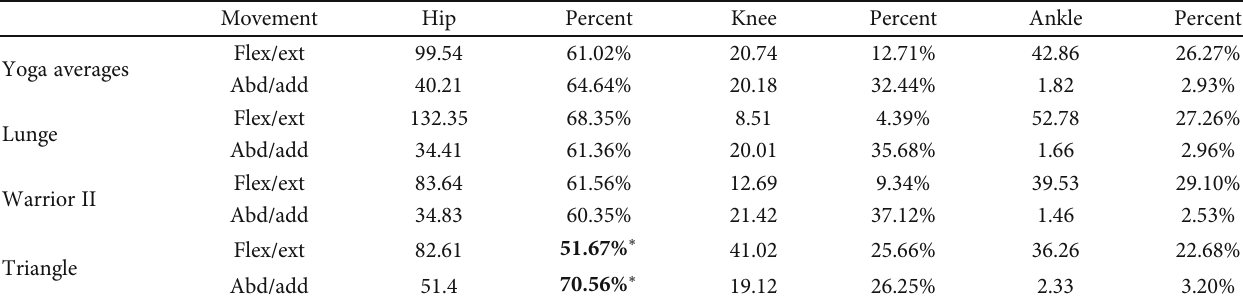
Table 3: Mean and standard deviation of the total angular impulses (Nm) in the sagittal and frontal planes.